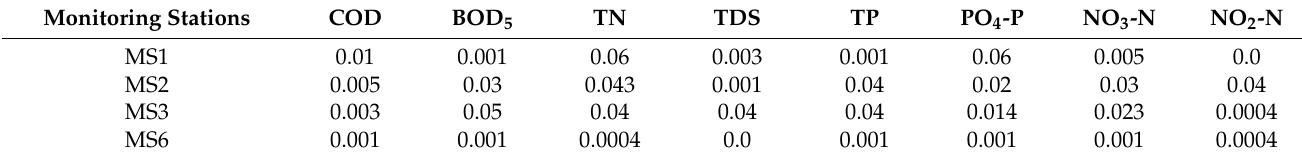
Table 7. Coefficient of variation (CV) for monitoring stations in